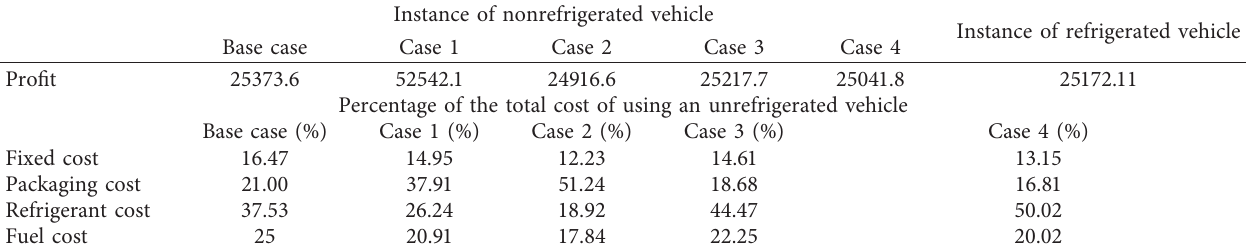
Table 6: Calculation results for each case.